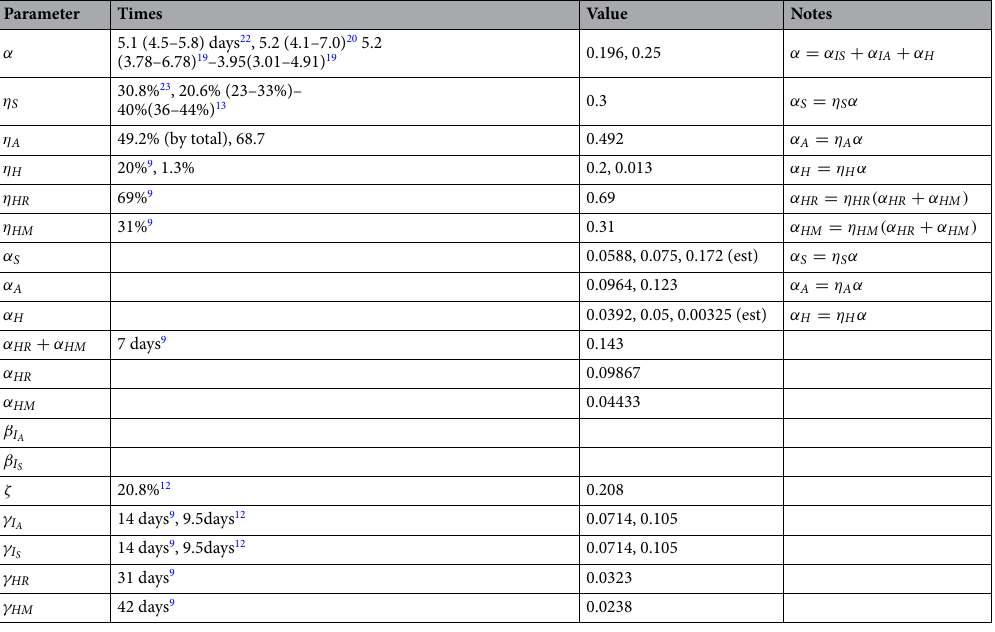
Table 1. Published times for compartmental conversions, proportions, and derived